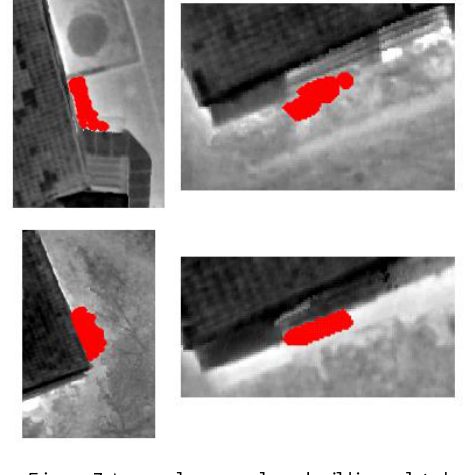
Figure 7 Anomaly examples – building related